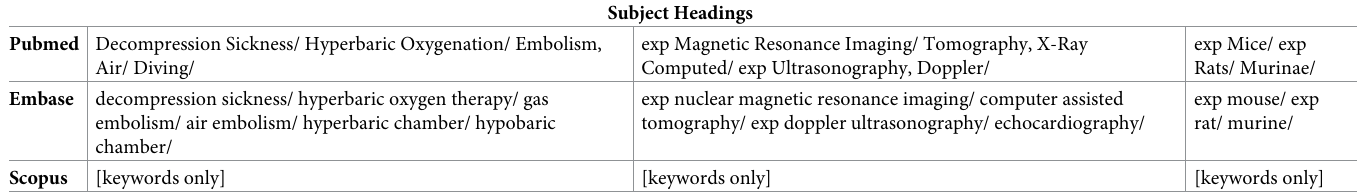
Table 3. Selected subject headings framework.